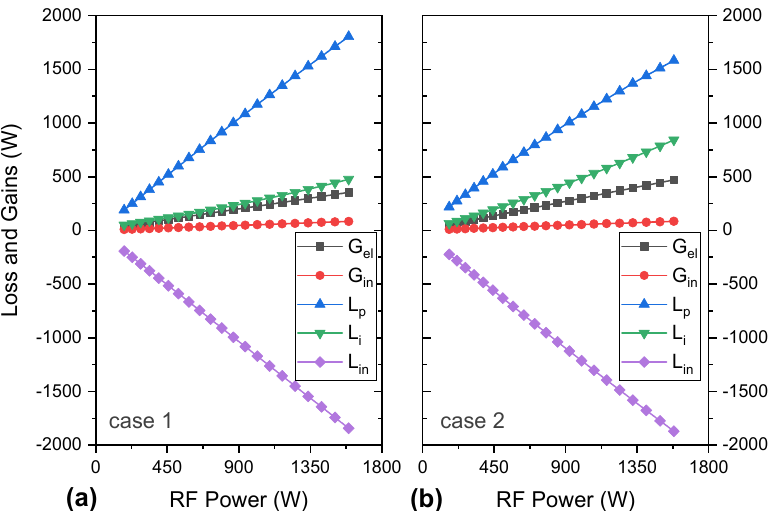
Figure 5. Comparison of the contributions of the gain and loss terms of the differential equation of neutral energy balance of the gas presented in Equation (10) for both cases: with ( a ) and without ( b ) Ar r and Ar p species, as a function of the RF power. Pressure = 2 mTorr.